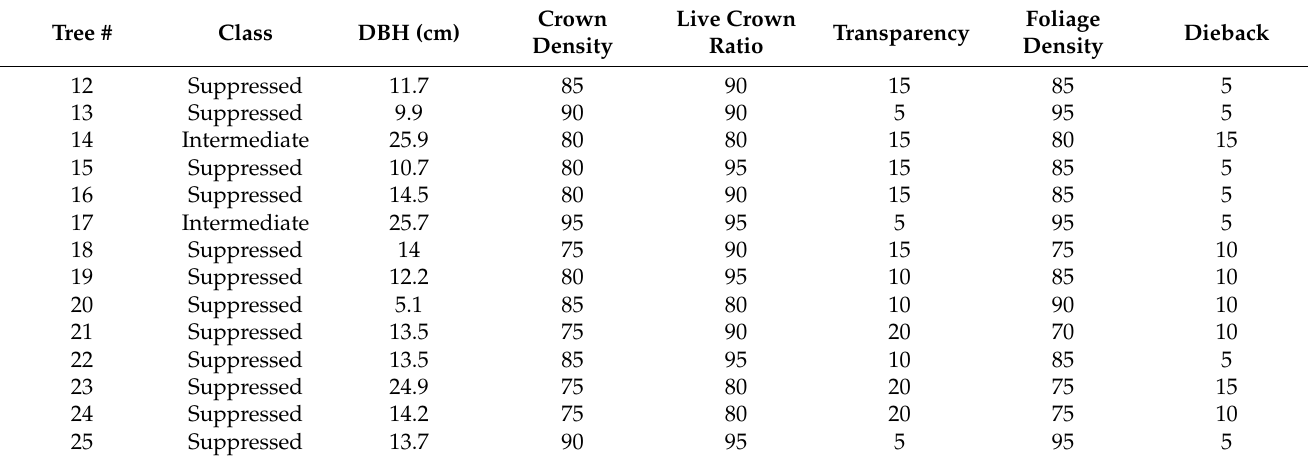
Table 1. Tree health assessment values, class classifications, and DBH measurements for each tree used at Gullion Fork near Wytheville, VA. Crown measures were based on a scale of 0–100.